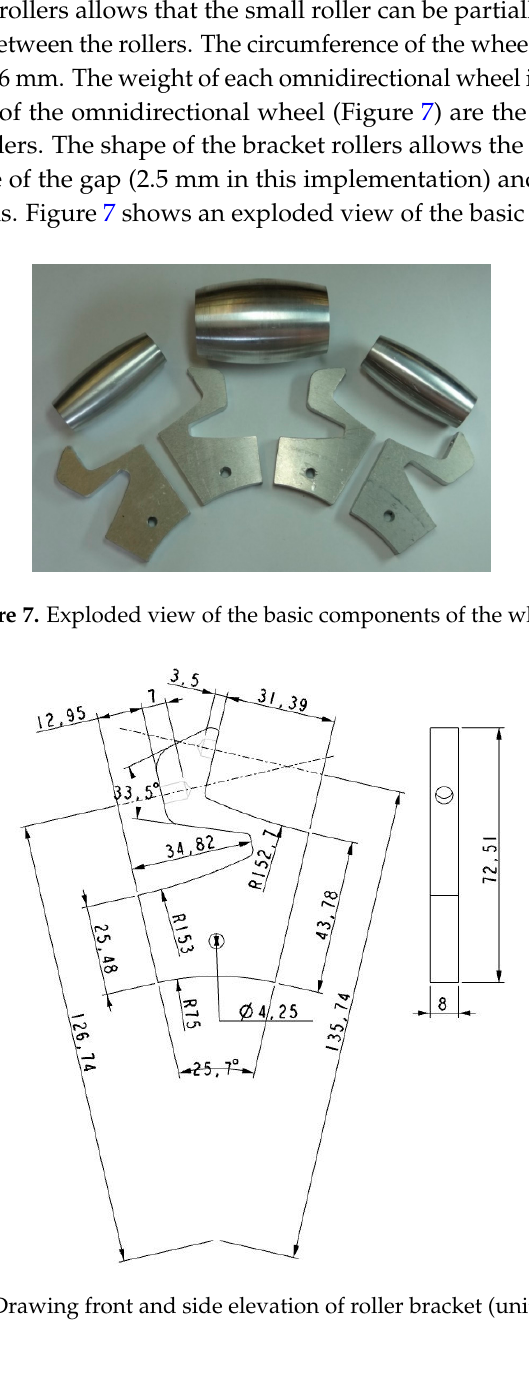
Figure 6. CAD section showing the alternate use of the two passive roller types.